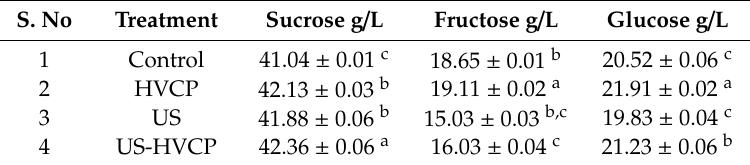
Table 3. Combined e ff ect of blanching and HVCP on sugar content in carrot